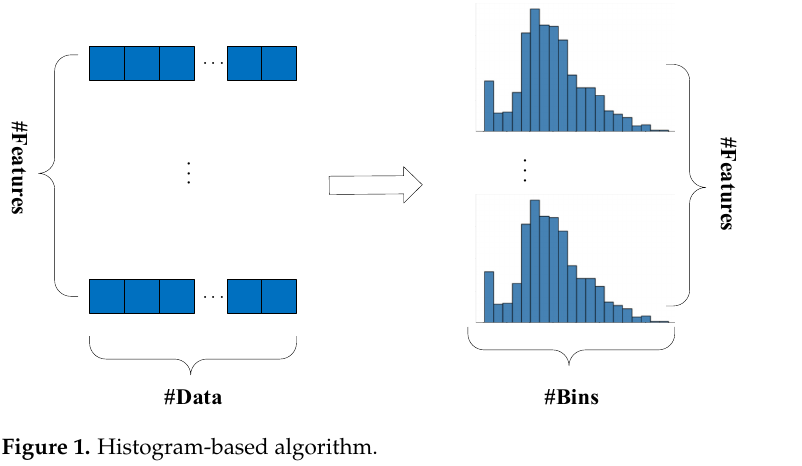
Energies 2022 , 15 , x FOR PEER REVIEW